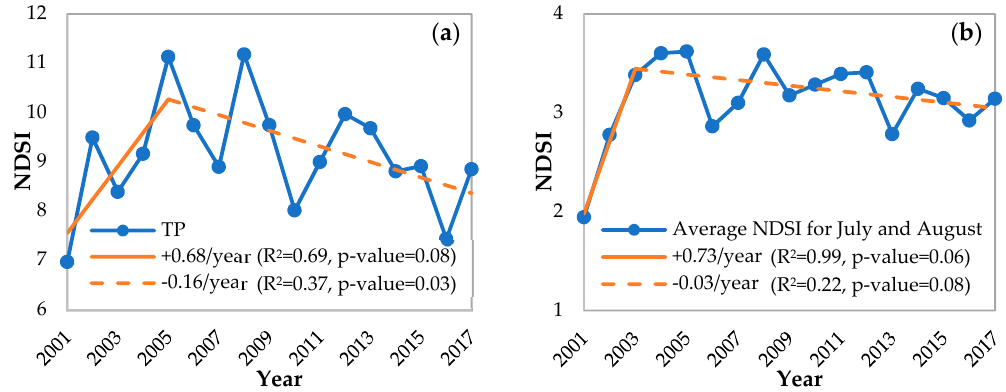
Figure 15. The average NDSI over the TP during 2001–2017. ( a ) The annual average NDSI. ( b ) The average NDSI for July and August.